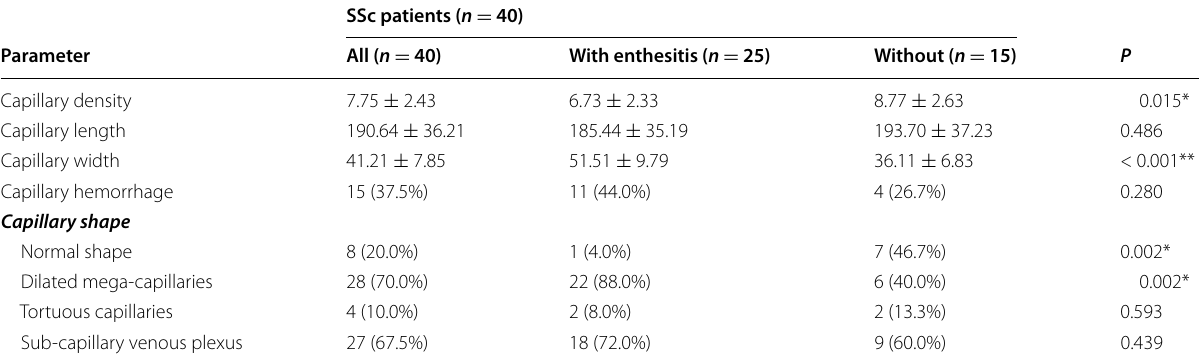
Table 3 Comparison between scleroderma patients with and without enthesitis detected by ultrasound according to various nailfold capillaroscopic